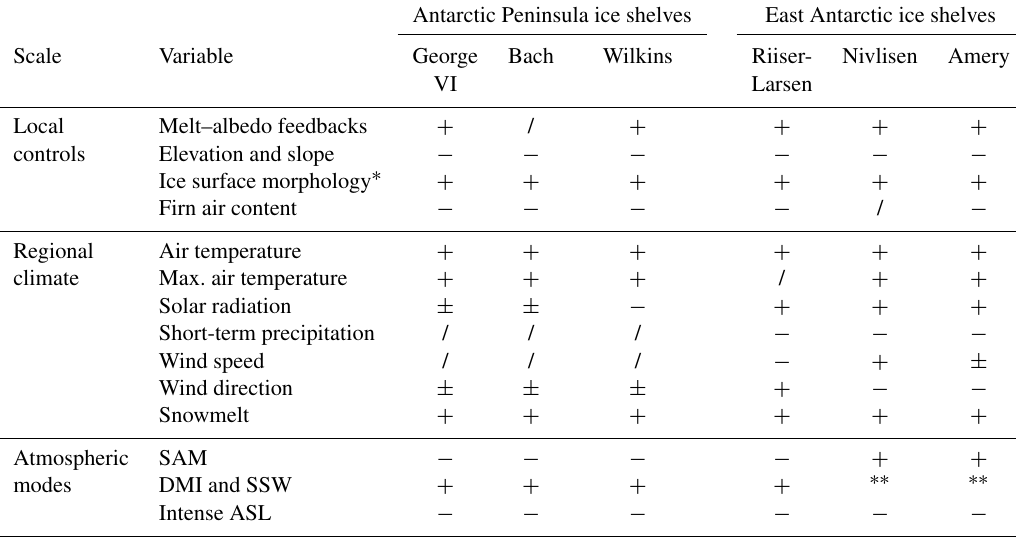
SAM modes DMI and SSW Intense